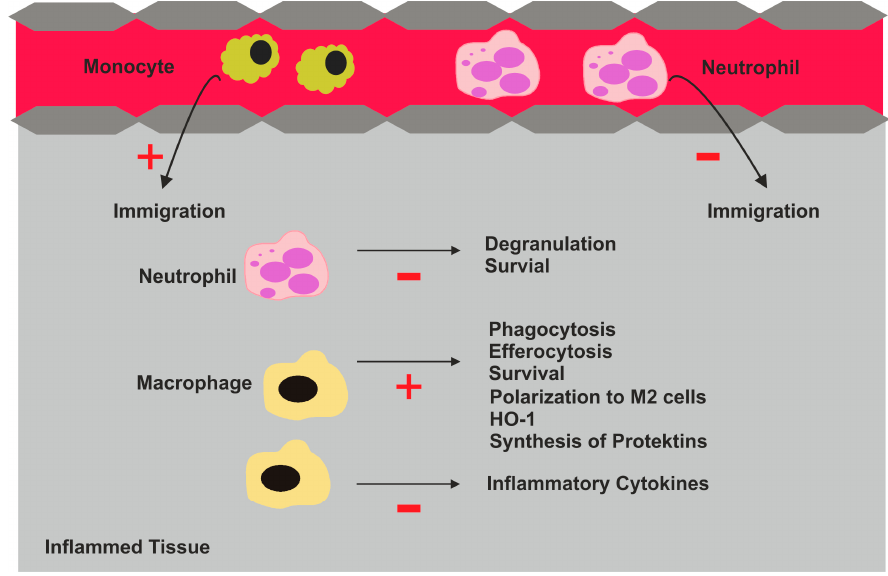
Figure 5. Biologic effects of pro-resolving lipid mediators in inflamed tissues. These lipid species reduce neutrophil immigration, degranulation and survival. They enhance the recruitment of monocytes. These cells differentiate to macrophages, and pro-resolving lipid mediators enhance phagocytosis, efferocytosis and survival. These lipids also promote the polarization of macrophages to M2 cells and induce heme oxygenase 1 (HO-1) and synthesis of protectins. Release of inflammatory cytokines is reduced; +, increase; − , reduction.